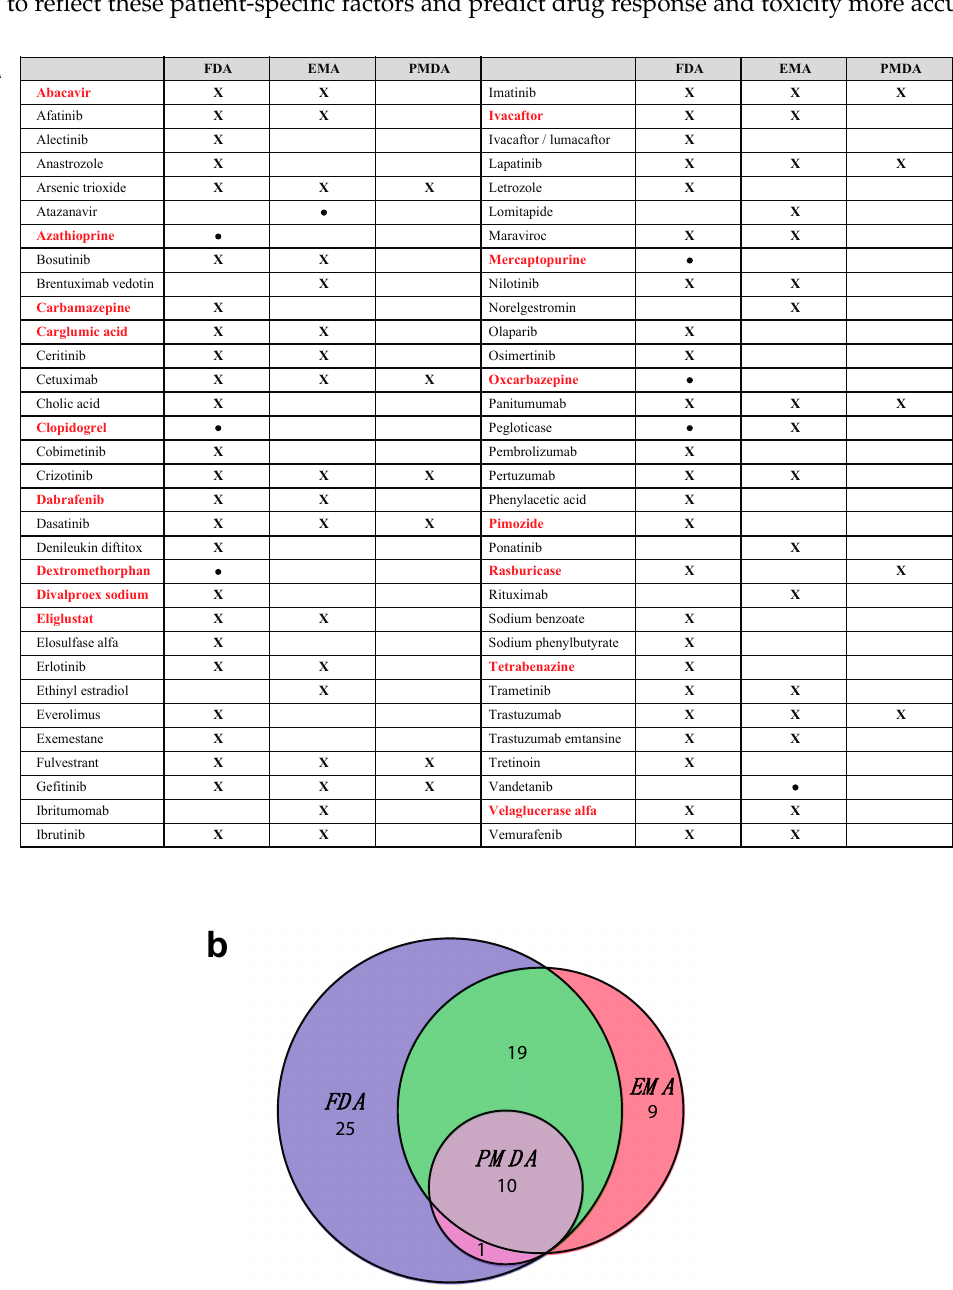
Figure 1. Drugs for which pharmacogenetic testing is recommended or required by major regulatory authorities: ( a ) Medications that require pharmacogenetic testing are indicated with “X”. If testing is only recommended, drugs are indicated with “ ● ”. Requirements and recommendations by American (FDA), European (EMA) and Japanese (PMDA) regulatory authorities are shown. Note that only few medications (indicated in bold red) overlap with drugs for which prescribing action is recommended by the Clinical Pharmacogenetics Implementation Consortium (compare Table 1); ( b ) Venn diagram visualizing the overlap of drugs for which pharmacogenetic testing is required or recommended across FDA, EMA and PMDA.